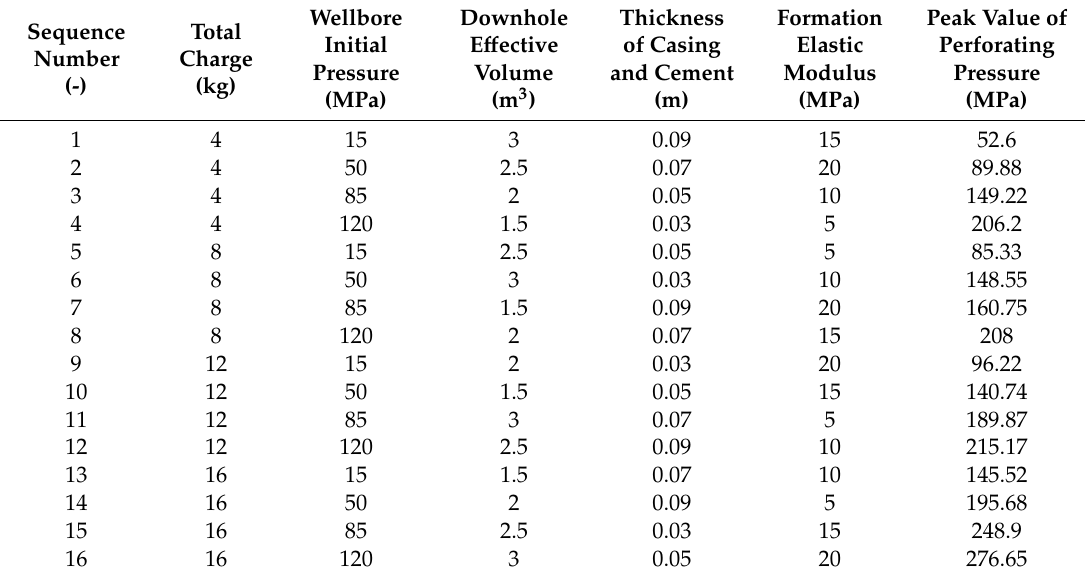
Table 7. Results of orthogonal